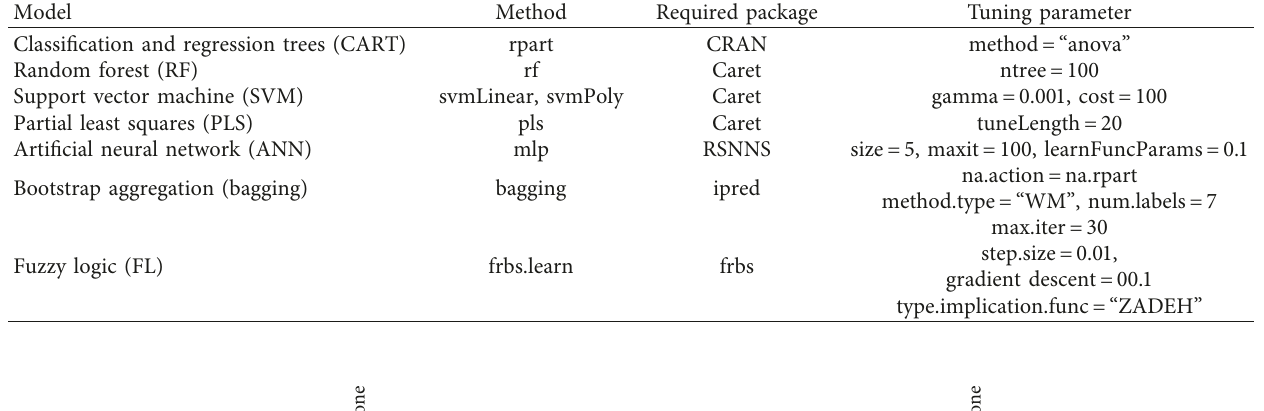
Table 3: Hyperparameters of machine learning regression models.